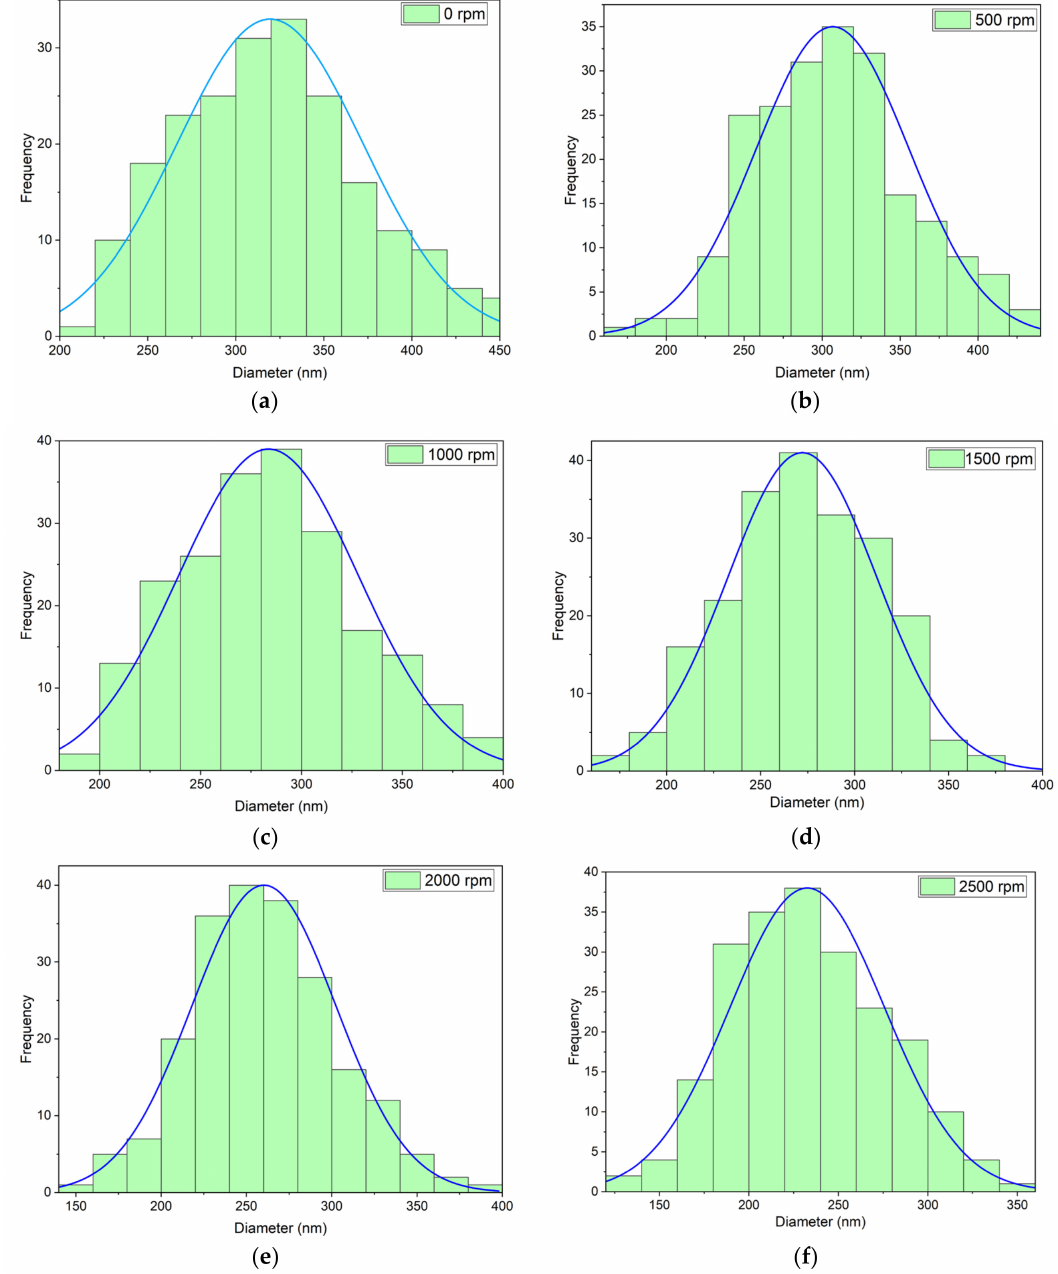
Figure 4. Diameter distribution of PVC nanofibers with different drum rotation speeds: ( a )—0 rpm (flat plate collector); ( b )—500 rpm; ( c )—1000 rpm; ( d )—1500 rpm; ( e )—2000 rpm; ( f )—2500